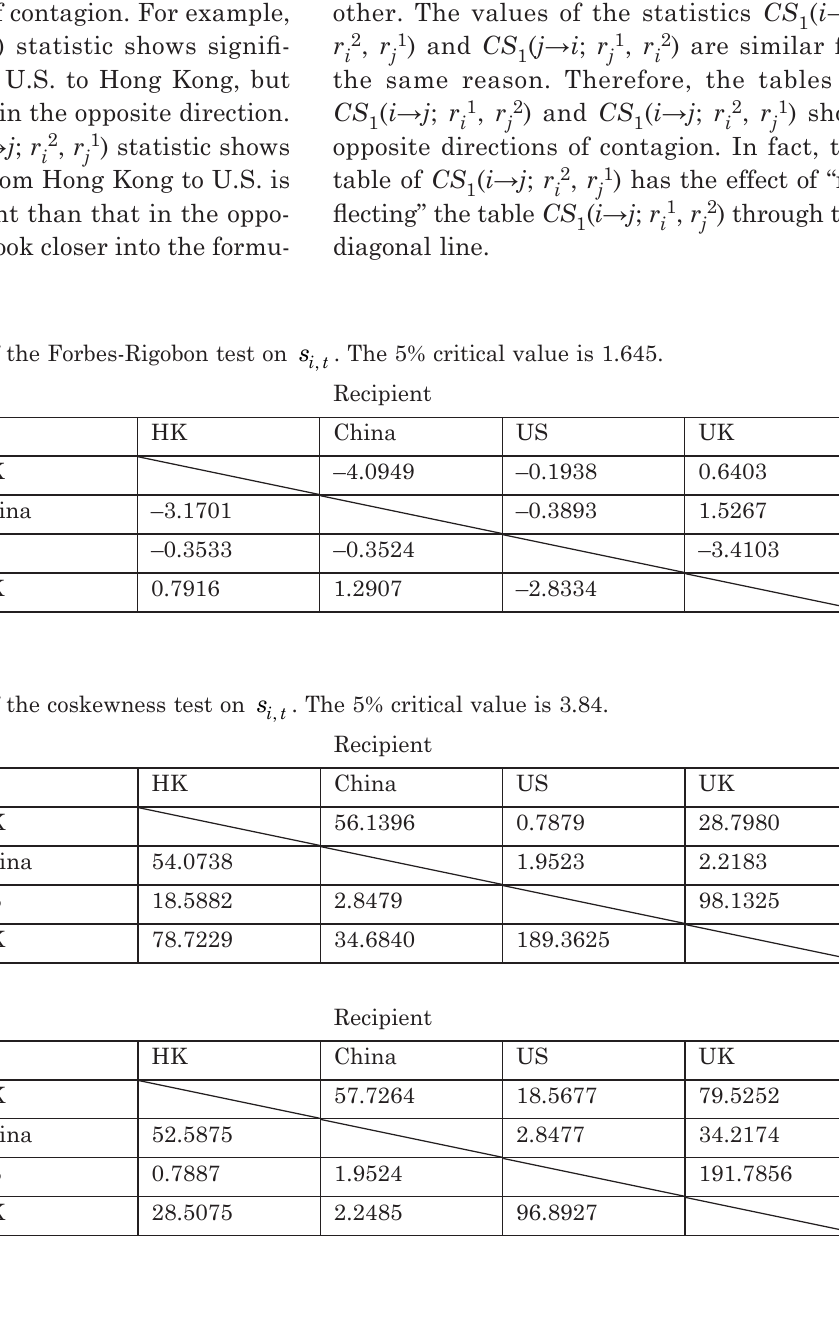
2 , r 1 ) has the effect of “re- ( i → j ; r 1 i j 1 , r 2 ) through the ( i → j ; r 1 i j